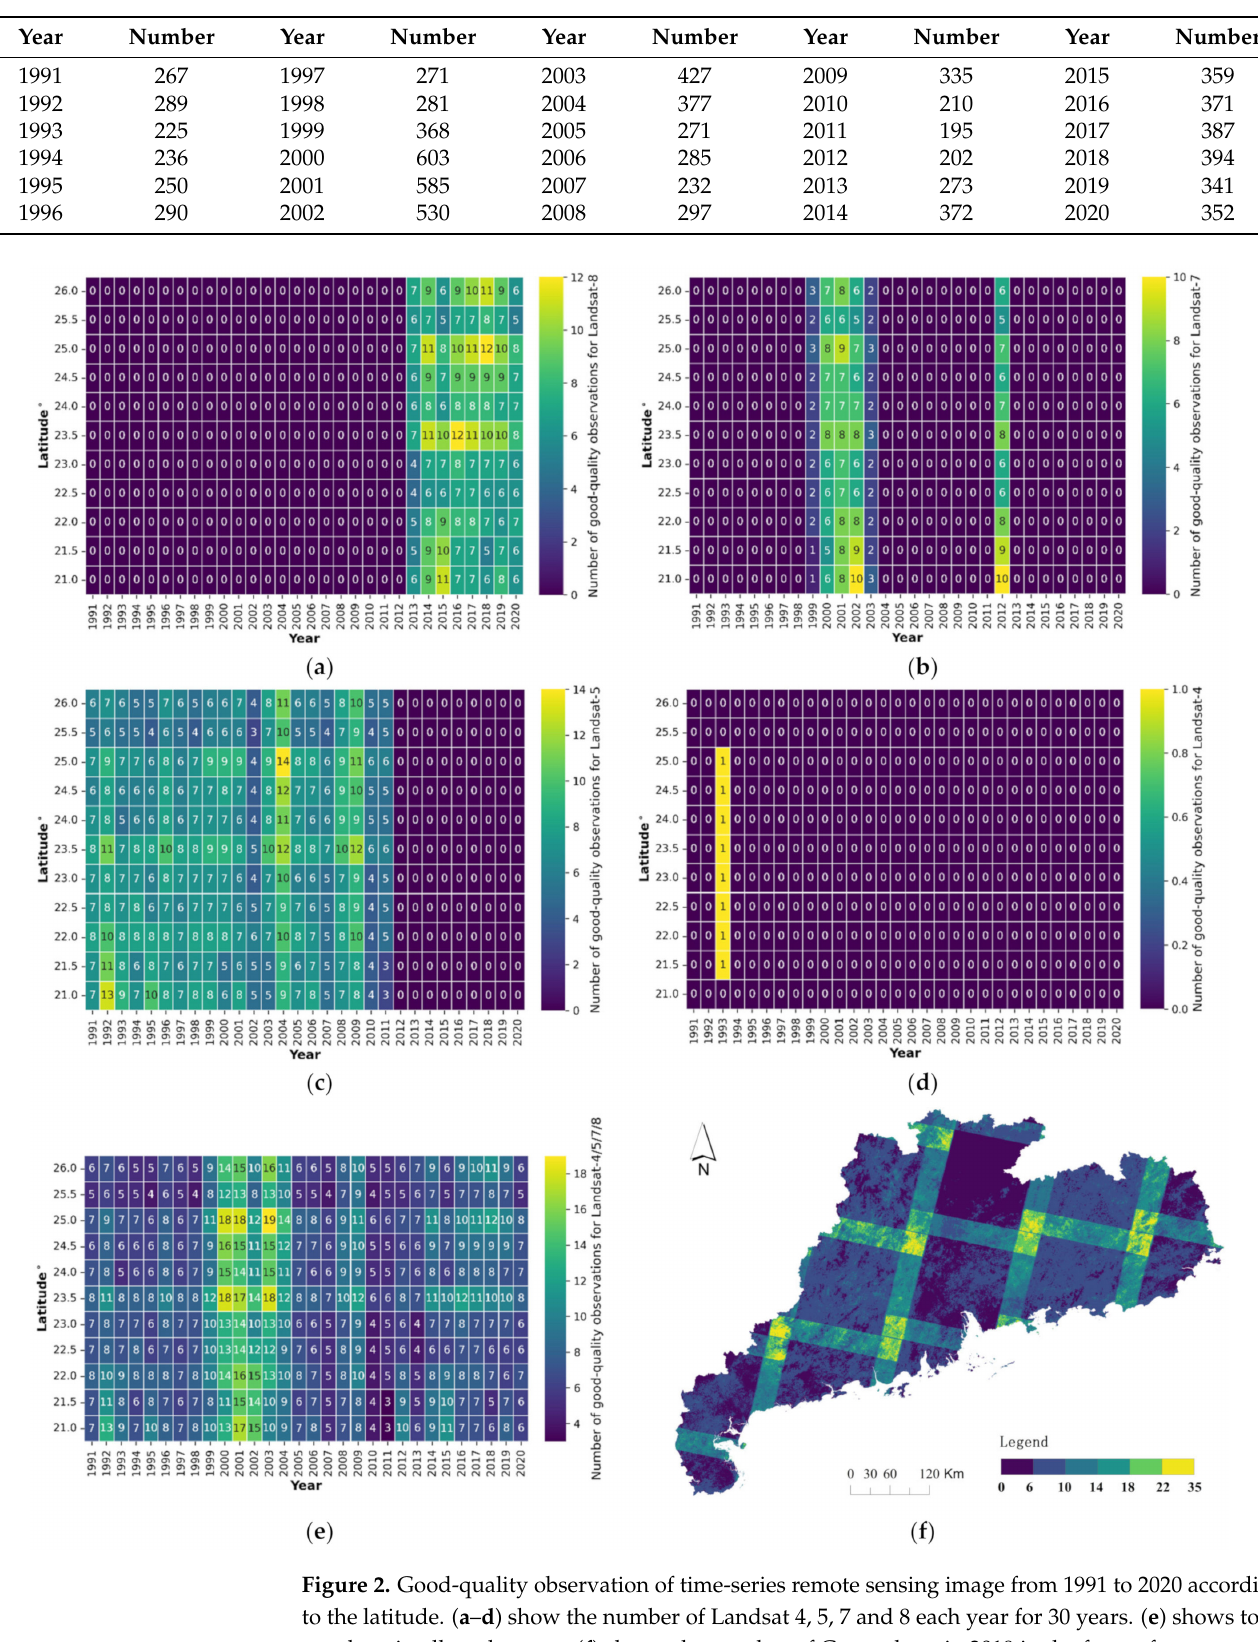
Table 1. Number of Landsat imagery used totally each year.